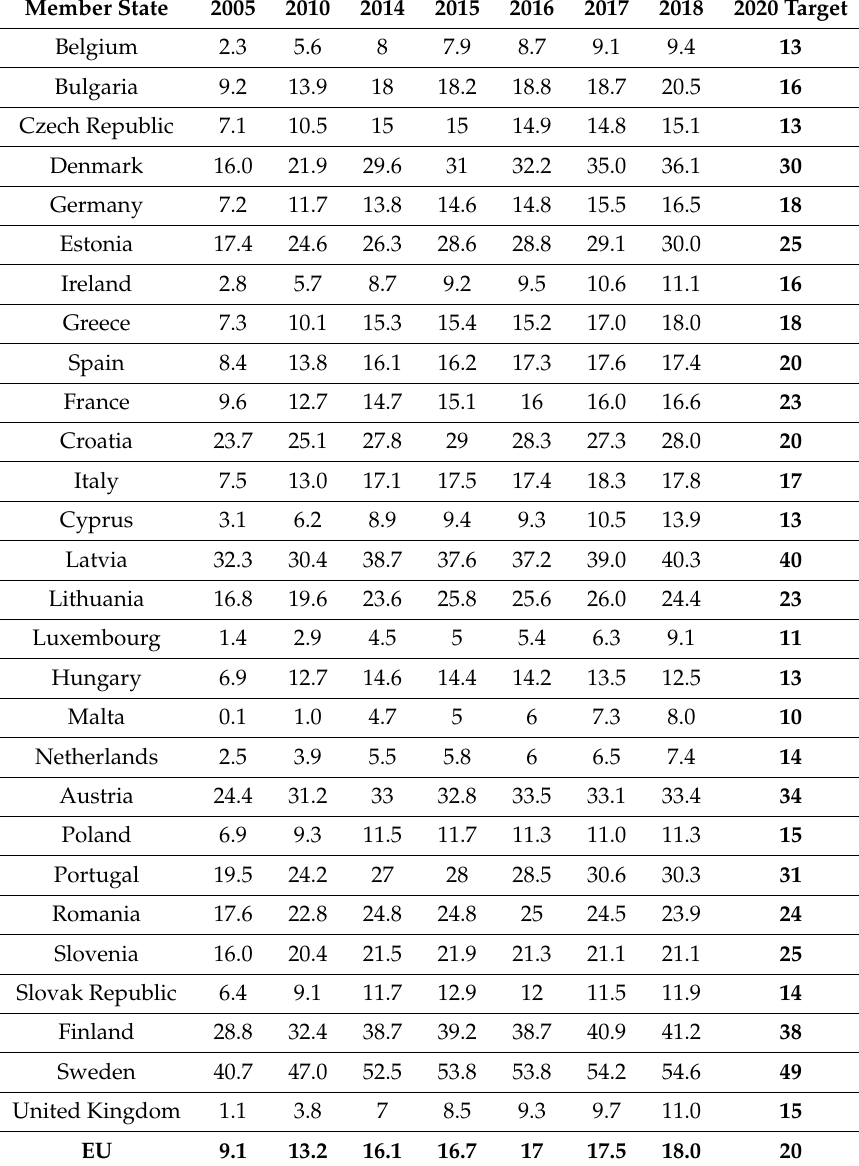
Table 1. Share of renewable energy in final energy consumption (%)